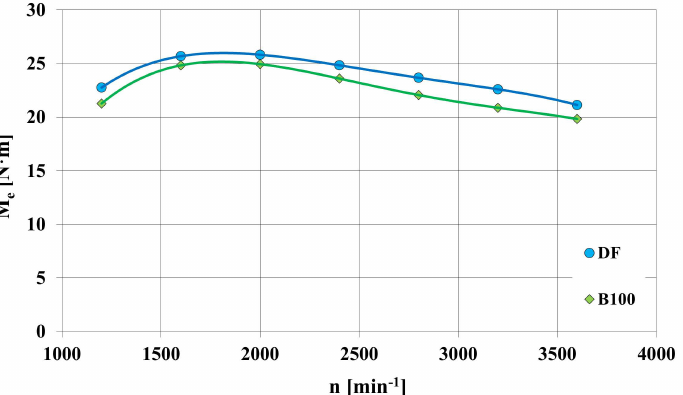
Figure 2. External speed characteristics of the torque-M e in the rotation speed domain-n for an engine fuelled with DF diesel or B100 fuel.